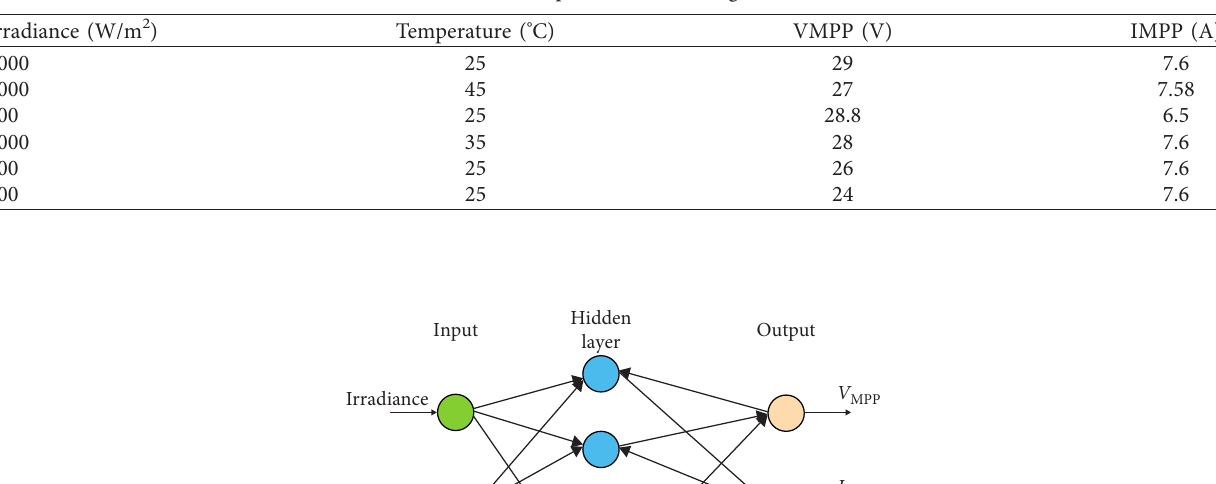
Table 3: Example of used learning